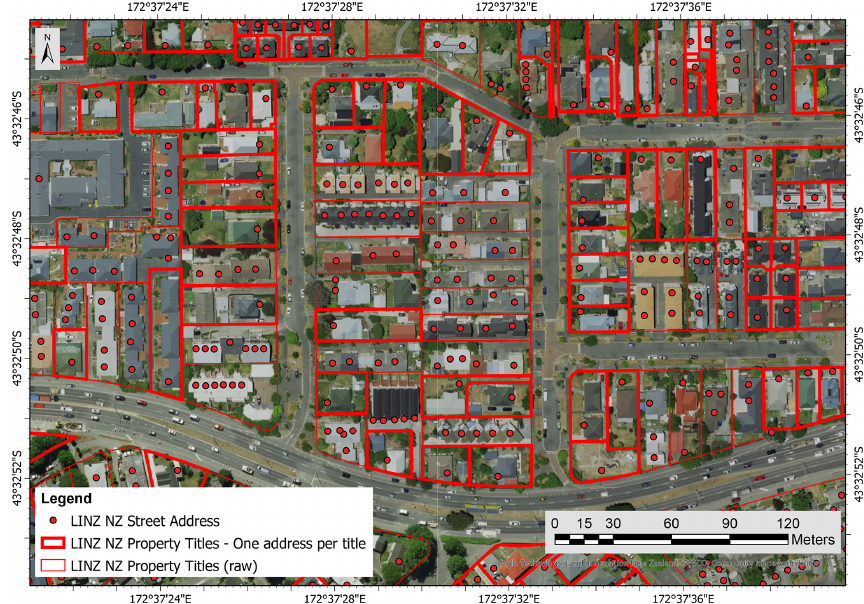
Figure 3. Satellite image of urban blocks in Christchurch overlaid with the LINZ NZ Addresses and LINZ NZ Property Titles layers. The polygons with a bold red border represent LINZ NZ property titles having only one street address (background layer from Eagle Technology Group Ltd; NZ Esri Distributor).